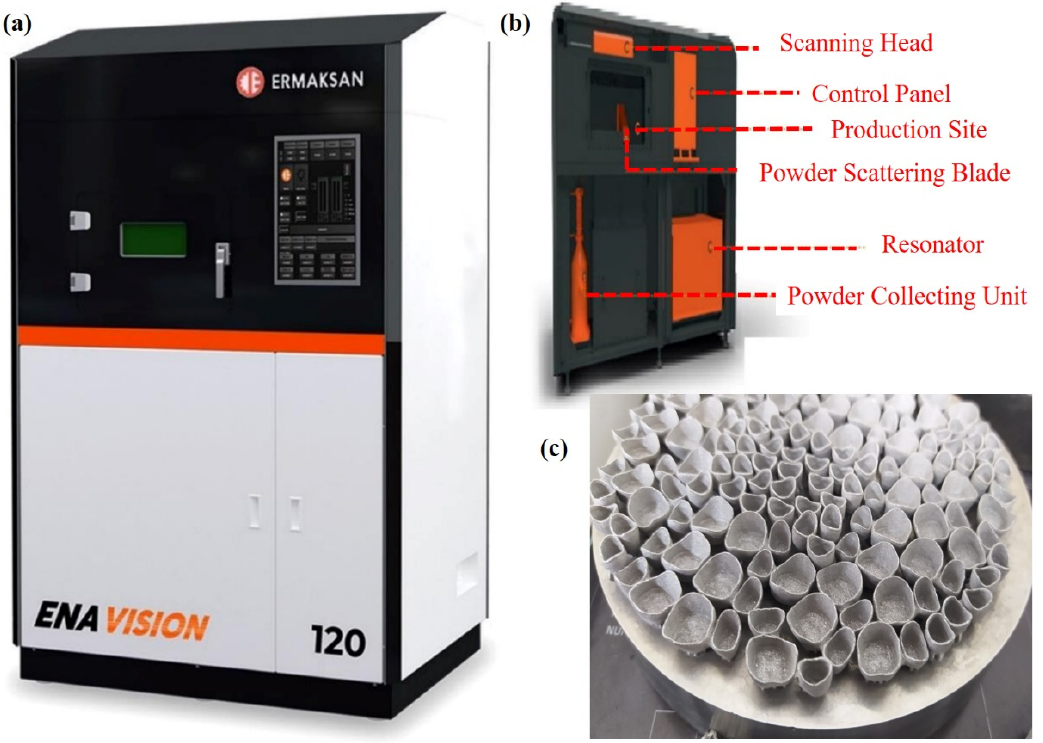
Figure 3. ( a ) ENAVISION 120 machine, ( b ) nomenclature of the machine, and ( c ) Co–Cr specimen printed by LPBF.